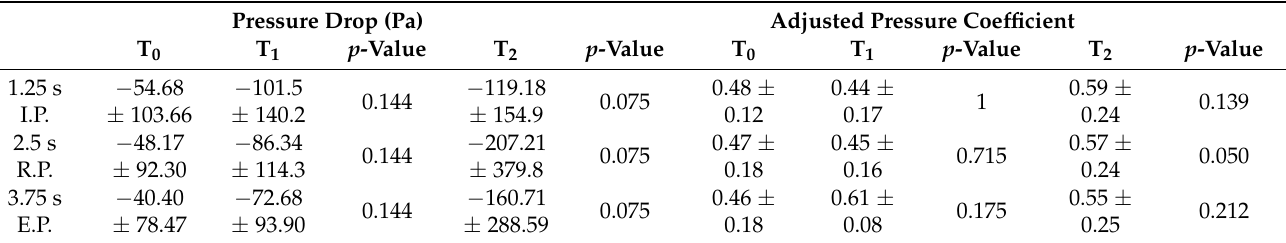
Table 5. Results of the CFD simulations (mean +